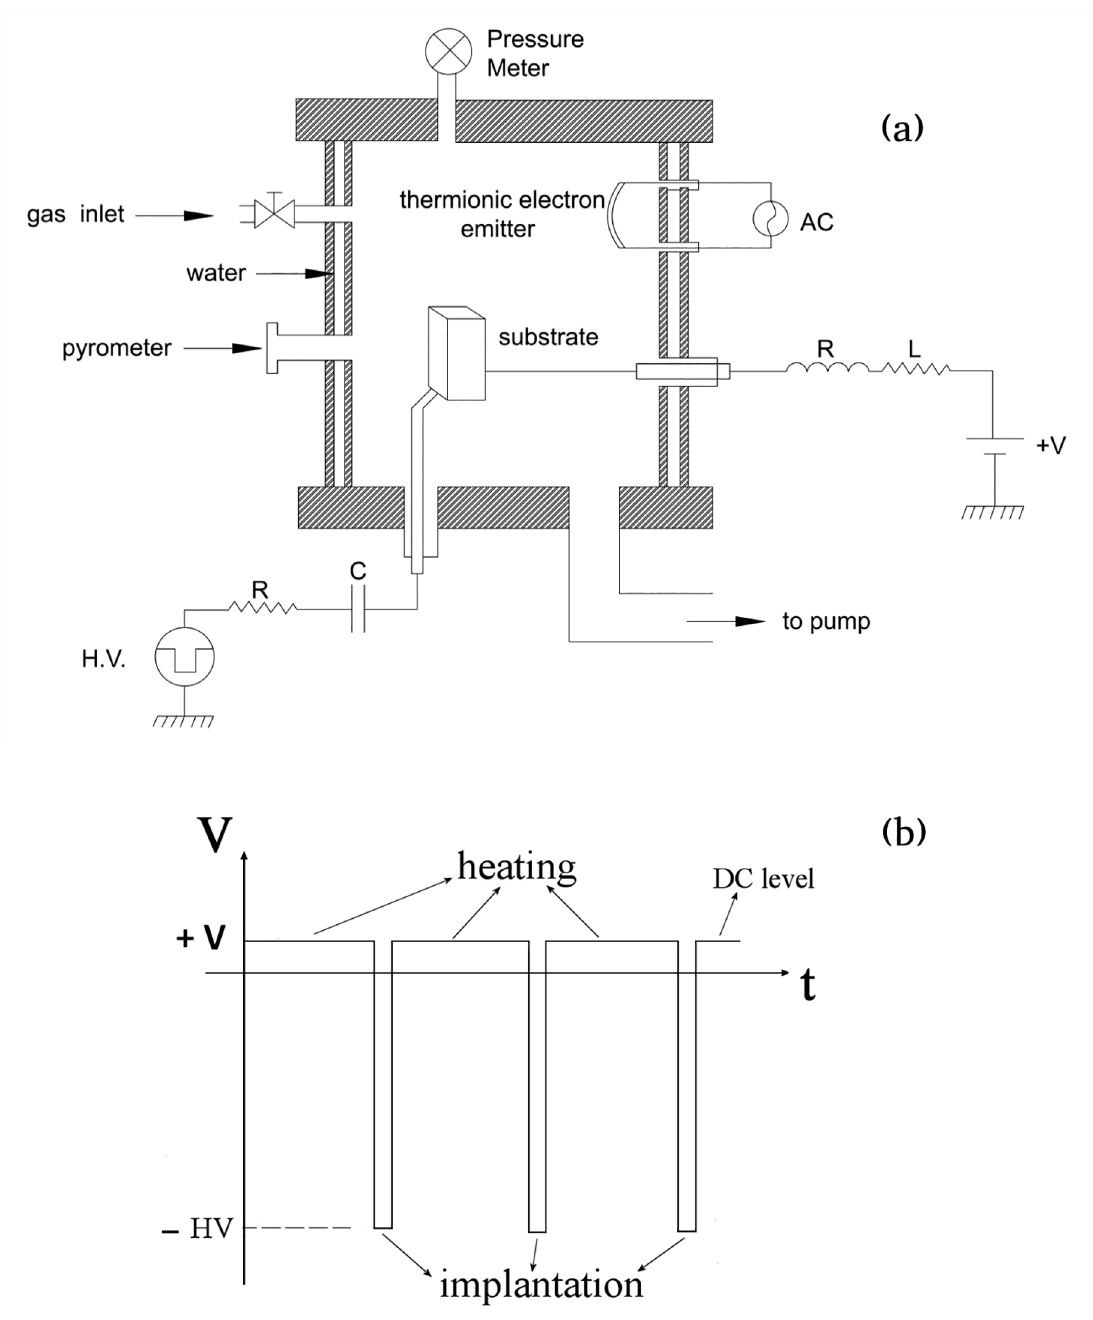
Figure 2. (a) Experimental apparatus of HT-NPBII; (b) diagram (off-scale) indicating the heating cycle and the ion implantation cycle in a sequence of high negative voltage